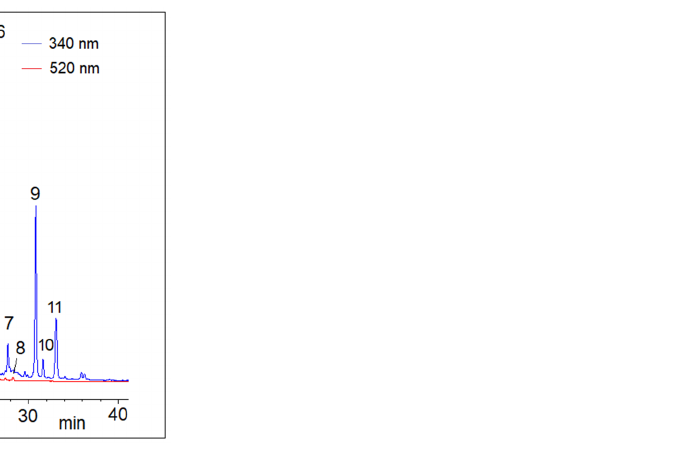
Figure 8. Representative HPLC chromatograms of a sweet cherry (poly)phenol extract monitored at 340 (blue line) and 520 nm (red line). Peaks labelled in the figure are assigned from Table 3. * caffeic acid dimer not quantified.